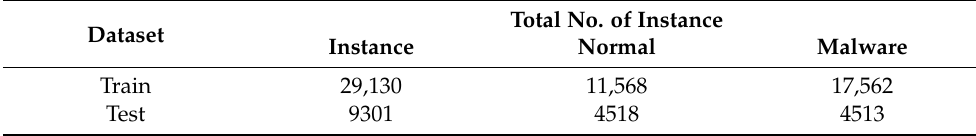
Table 4. Composition of the 2019 KISA Data Challenge